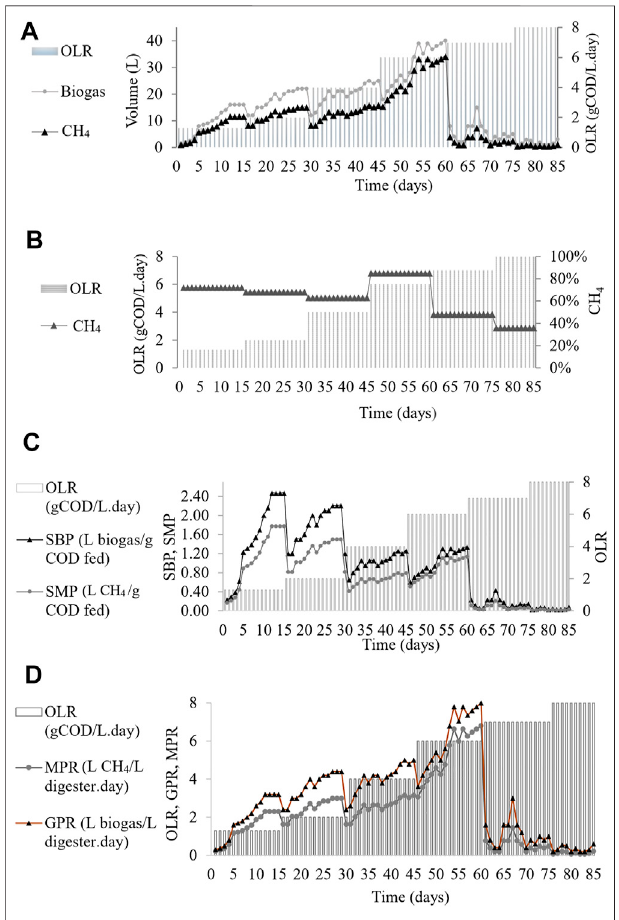
FIGURE 3 | CMFW digestion performance in CSTR. (A) Biogas and methane yield. (B) Methane composition. (C) Speci fi c biogas and methane production. (D) Biogas and methane production